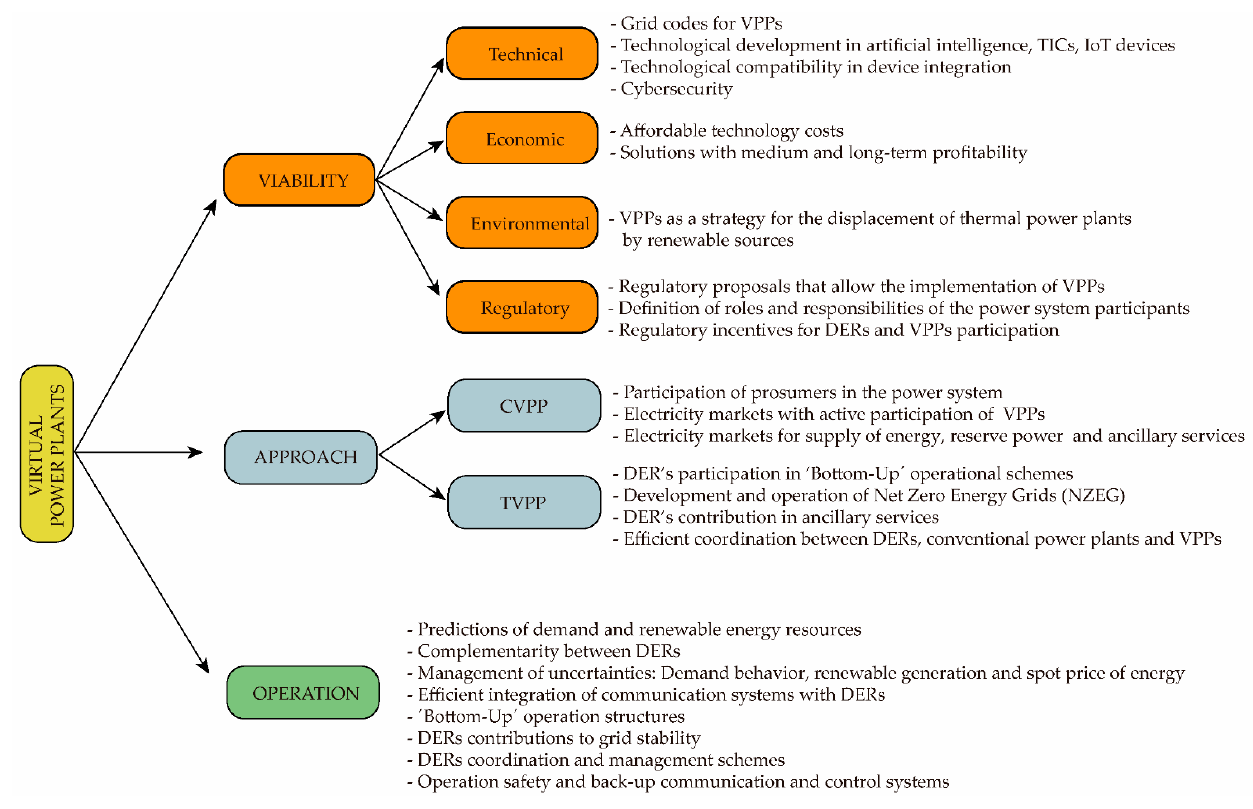
Figure 9. Research challenges and development for the large-scale implementation of VPPs .